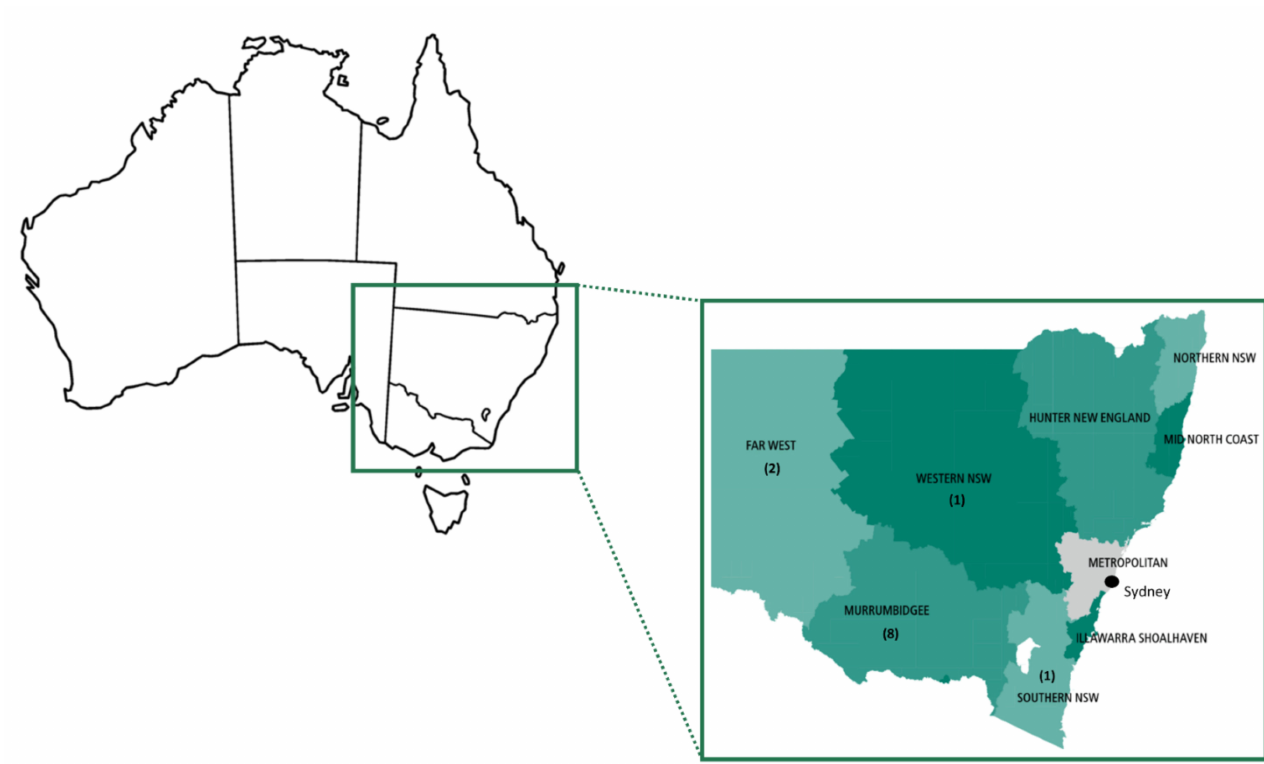
Figure 2. Location of confirmed cases of Japanese encephalitis in New South Wales by local health district. Number of cases for each local health district indicated in